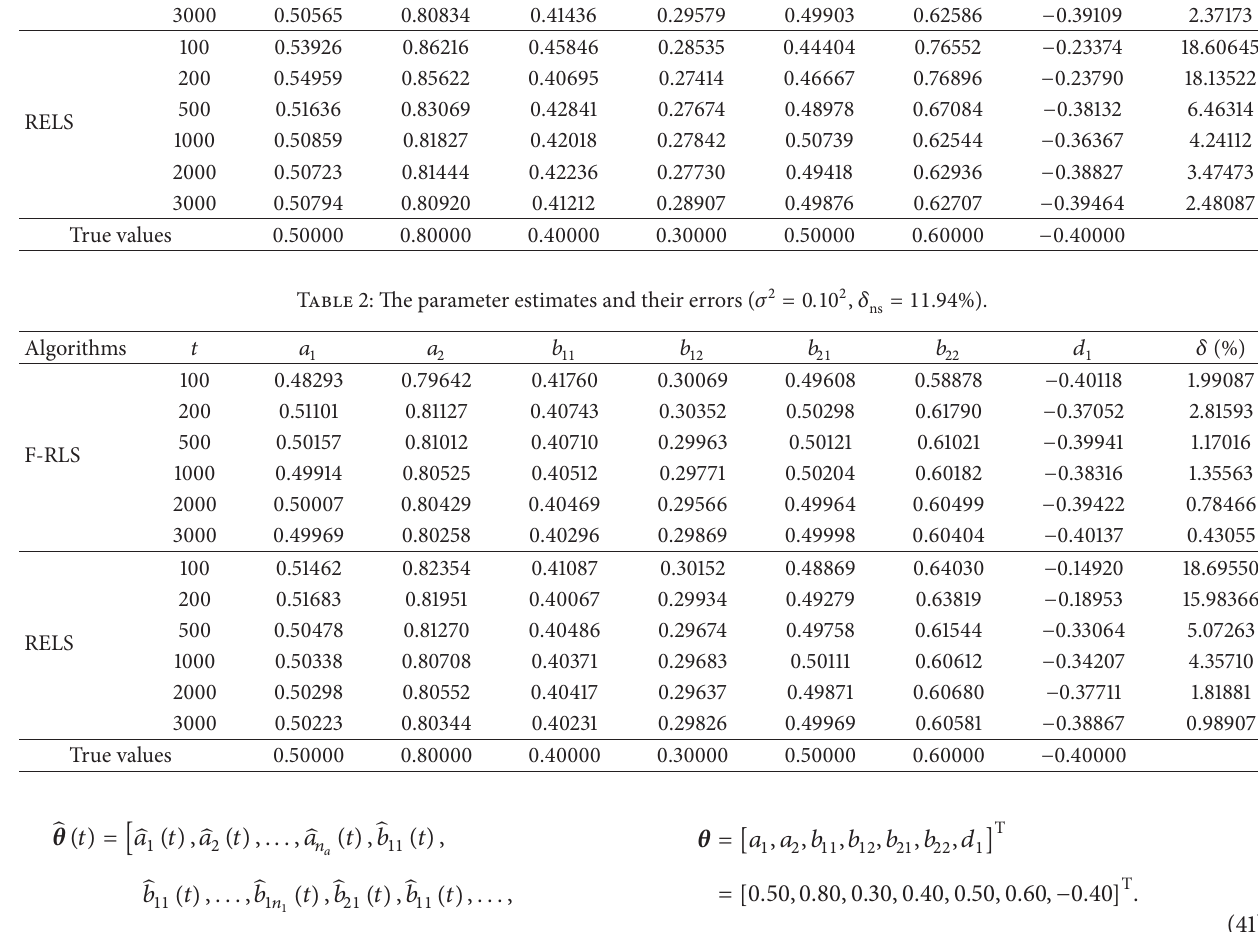
Table 1: The parameter estimates and their errors ( 𝜎 2 = 0.50 2 , 𝛿